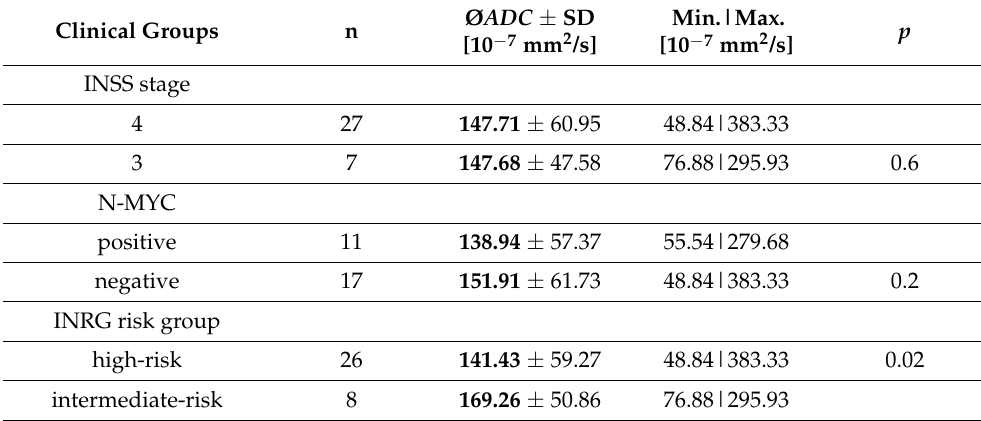
Figure 3. Boxplot representation of the ADC values of the tumor manifestation divided into INRG risk groups ( left ) and N-Myc status ( right ) with the mean of all measurements plotted as a reference. While the ADC values as a function of N-Myc status did not differ significantly ( p = 0.2), the difference in ADC values for the INRG risk groups was statistically significant regardless of the location of the tumor ( p = 0.02). (dashes = mild outliers; triangles = extreme outliers). A statement on the course of the disease was available for 70 measured values, and a Table 2. Mean ADC values (bold) ± standard deviation (min.|max.) of all tumor manifestations corresponding reference point (BL) for the calculation of ∆ ADCvalues could be depending on the clinical parameters and associated groupings or the molecular status. Within determined. the respective parameter groups, there was only a significant difference in the ADC mean values stratified according to the INRG risk group between the high-risk group and the intermediate-risk group ( p =